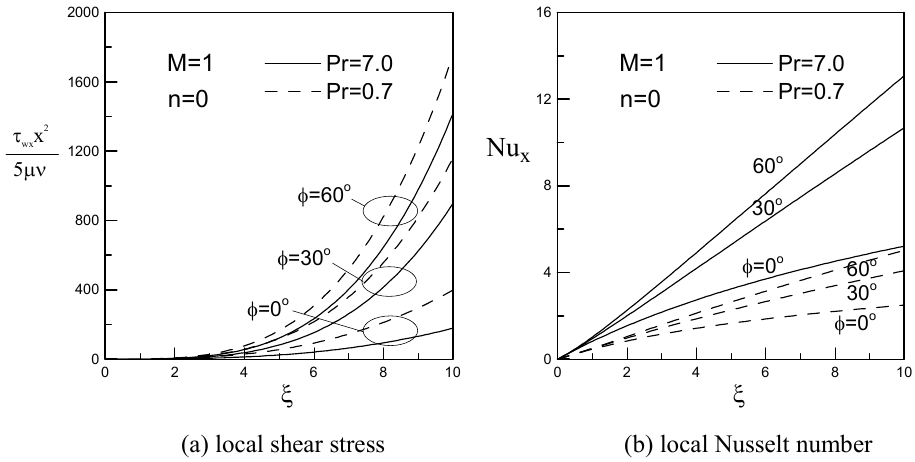
Figure 5 The local shear stress and Nusselt number over a wide range of ξ for specified φ =0°, 30°, 60° with M=1, n=0 and Pr=0.7, 7.0. The corresponding local wall shear stress τ in terms of ( τ x 2 /5 µν ) and local Nusselt wx wx number Nu over a wide range of ξ for various inclination angles φ  are shown in Fig. 5. It is x expected that both the wall shear stress and heat transfer rate increase with rising inclination angle φ . This is because the velocity gradient near the plate increases as φ  increases.